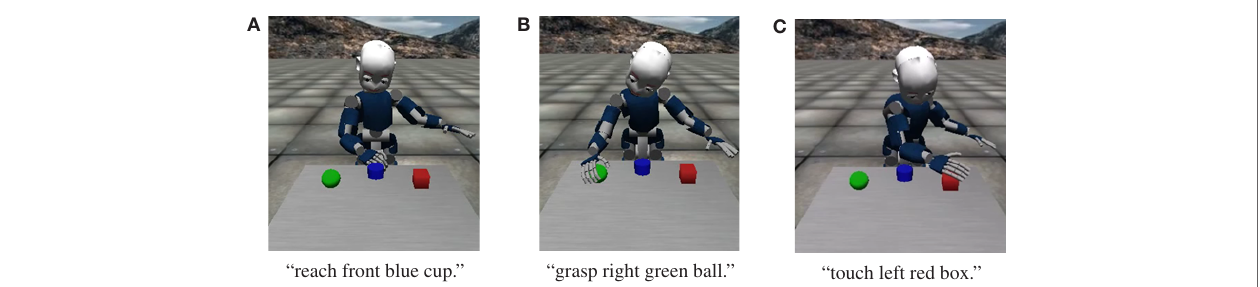
FIGURE 5 | Example of results of the action generation task in the iCub simulator. (A) Reach front blue cup. (B) Grasp right green ball. (C) Touch left red box.